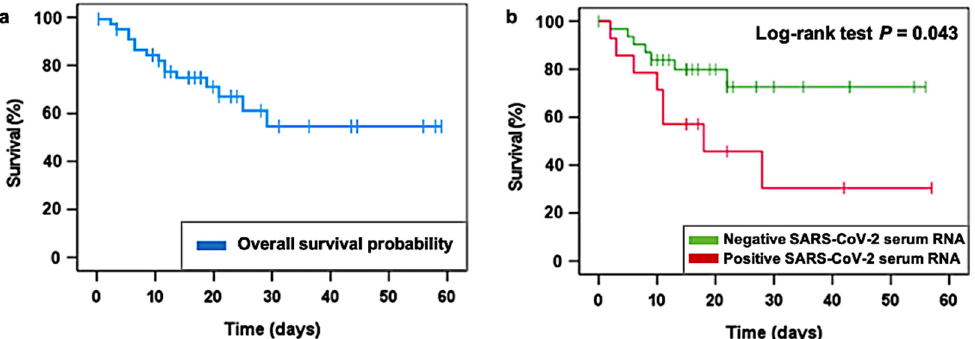
Figure 2. Overall survival (OS) estimates of COVID-19 patients treated with LDRT considering deaths due to COVID-19 pneumonia. ( a ) OS in the studied population ( N = 47). ( b ) 30-day OS of patients testing positive for SARS-CoV-2 serum RNA ( N = 14) and patients testing negative for SARS-CoV-2 serum RNA ( N = 29). p value obtained from a log-rank test.